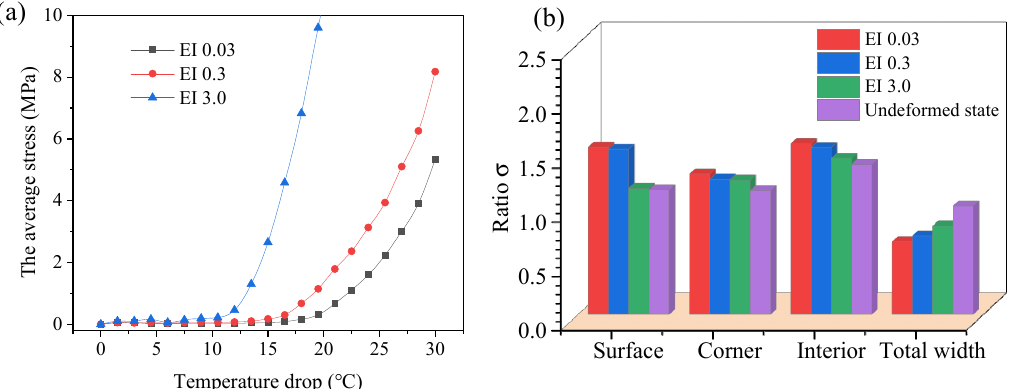
Figure 13. The effect of bending stiffness: ( a ) diagram of the average stress against temperature drop and ( b ) comparison of yarn deformation ratio and total width variation.